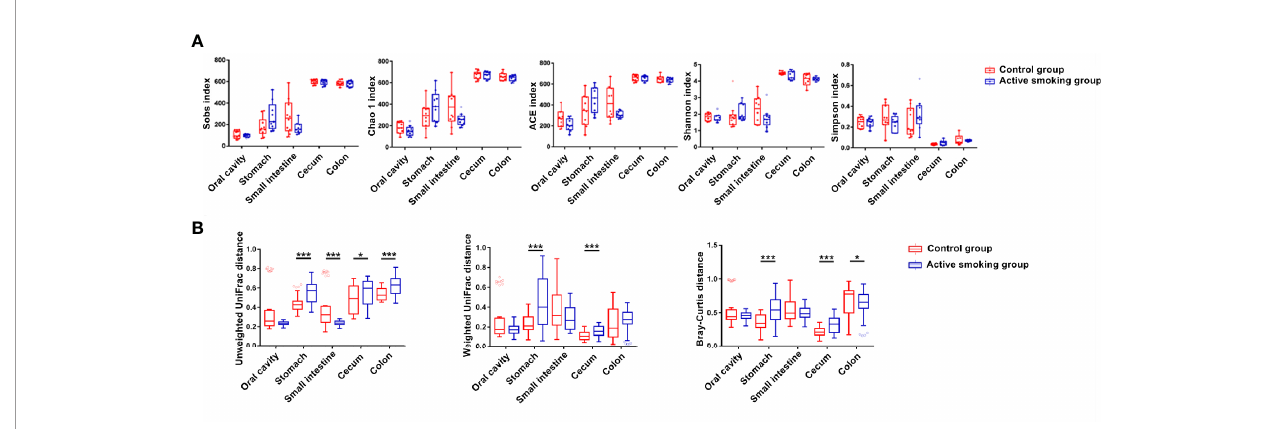
FIGURE 3 | Bacterial community structure along the digestive tract of rats in the active smoking group compared with the control group. (A) Box plots of alpha diversity measured by fi ve indices. Boxes denote the interquartile range (IQR) between the fi rst and third quartiles, and the line inside the boxes denote the median. Circles represent data points beyond the whiskers. (B) Pairwise comparison of median unweighted, weighted UniFrac and Bray-Curtis distances between the active smoking group and control group. * and *** denote p < 0.05 and p < 0.001,